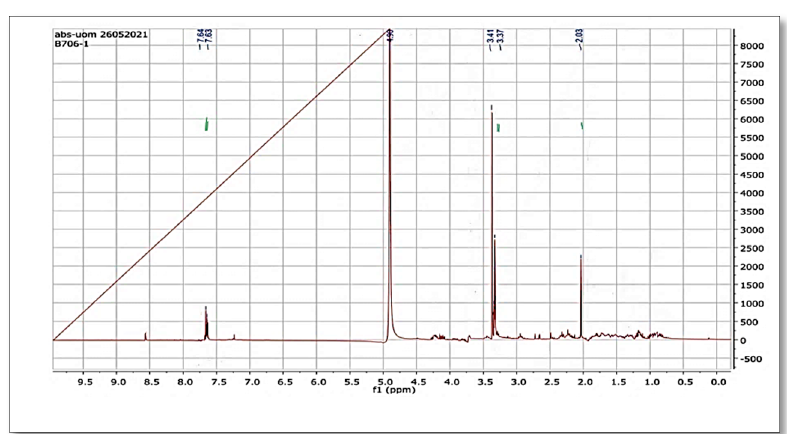
Figure 12. Original Dye Brown 706 13 C NMR.